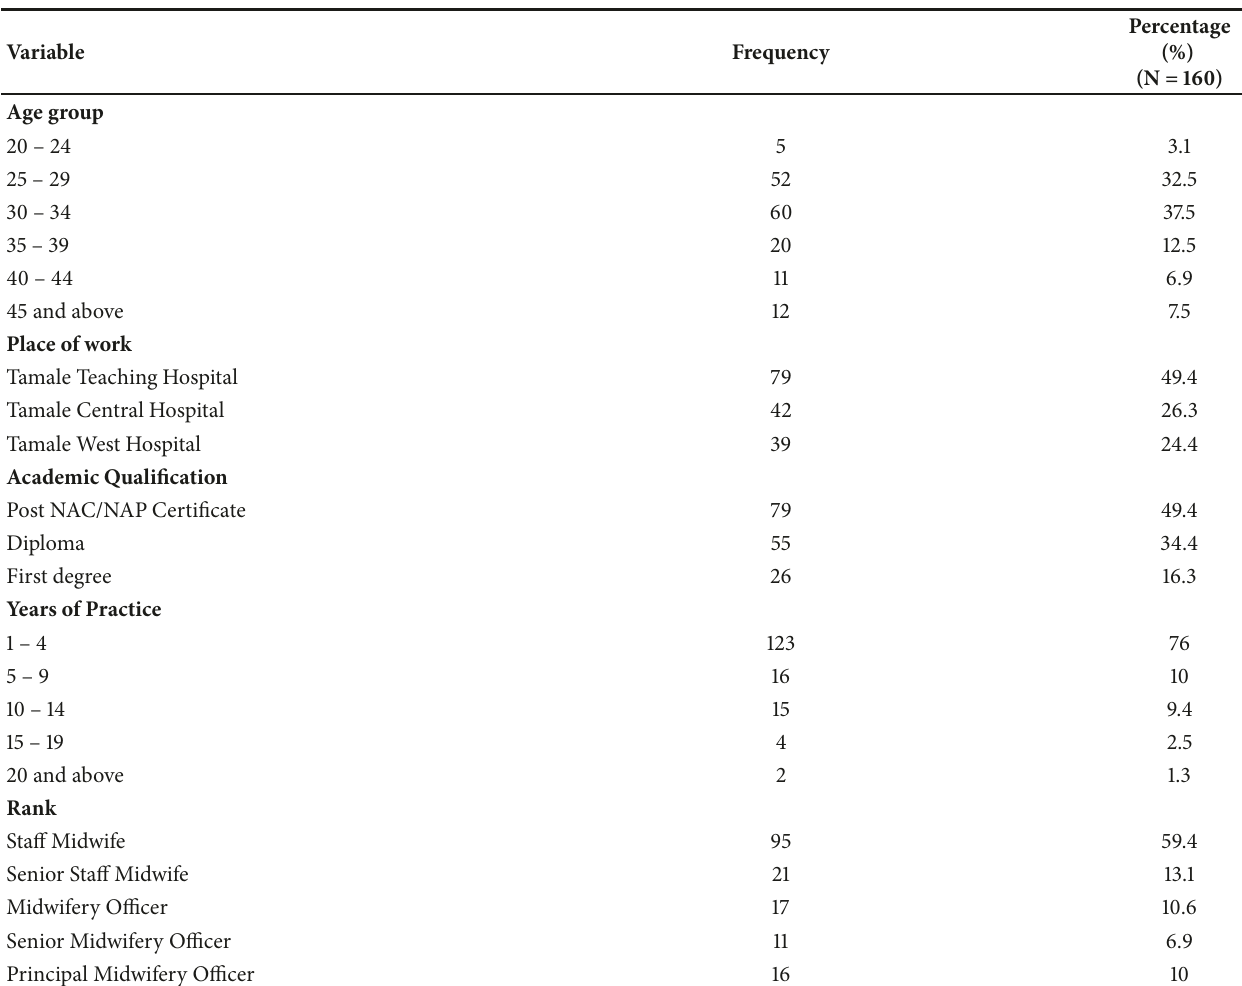
Table 1: Background characteristics of